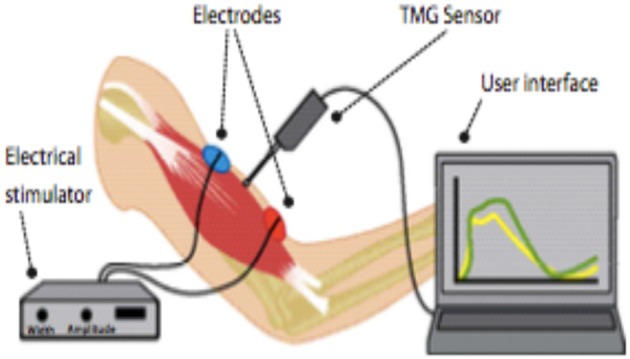
Components of TMG.